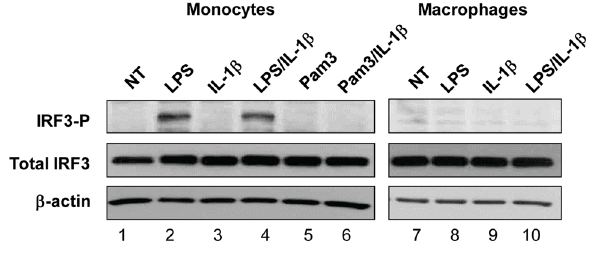
Figure 7. IRF3 is phosphorylated in monocytes but not in macrophages following activation with LPS. Monocytes (lanes 1– 6) and differentiated macrophages (lanes 7–10) were left untreated (lanes 1 and 7) or were treated for 1 h with: LPS alone at 1 ng/ml (lanes 2, 8); Pam3CSK4 alone at 50 ng/ml (lane 5); with IL-1 b alone at 100 ng/ ml (lanes 3, 9), or with LPS + IL1 b (lanes 4, 10); or with Pam3CSK4 + IL-1 b (lane 6). Following incubation, cell lysates were prepared and resolved in SDS-PAGE. Phospho-IRF3, total IRF3, and b -actin were detected after Western Blotting. The experiment was performed 3 times with similar